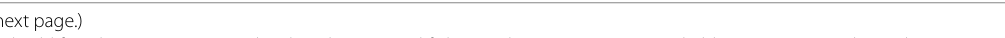
Fig. 1 A 1‑month‑old female patient presented with tachypnea and failure to thrive. a MDCT Coronal oblique MIP image showed PDA originate from aortic isthmus to LPA proximal segment, b Axial MIP image showed PDA connect between aortic isthmus and LPA with atretic MPA, c Axial MIP image showed coronary fistula with hypoplastic right ventricle, d Axial MIP image showed left sided aortic arch with aberrant RT SCA, e VR image showed PDA with type II tortuosity, f VR oblique lateral image showed PDA connecting aortic isthmus with proximal segment of LPA, g VR anterior view of the heart showed cameral fistula between right coronary artery and hypoplastic right ventricle, h VR oblique lateral view showed type E PDA originate from aortic isthmus to LPA. A case of hypoplastic right ventricle with pulmonary atresia and duct dependent